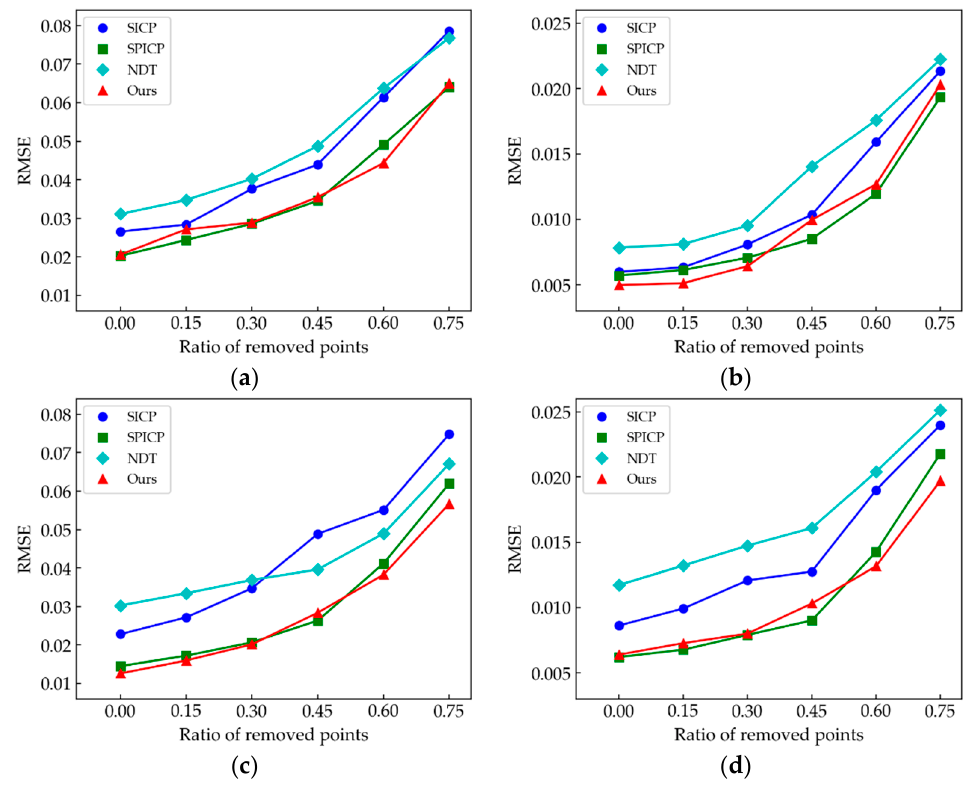
Figure 14. Evaluation of the impact of Poisson disk down-sampling with different sampling densities on the four algorithms. ( a ) Comparison results of M 1 point cloud; ( b ) M 2 ; ( c ) M 3 ; ( d ) M 4 .